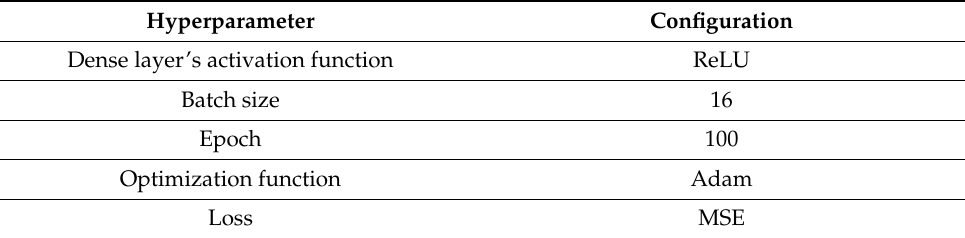
Table 2. Hyperparameter setting for used